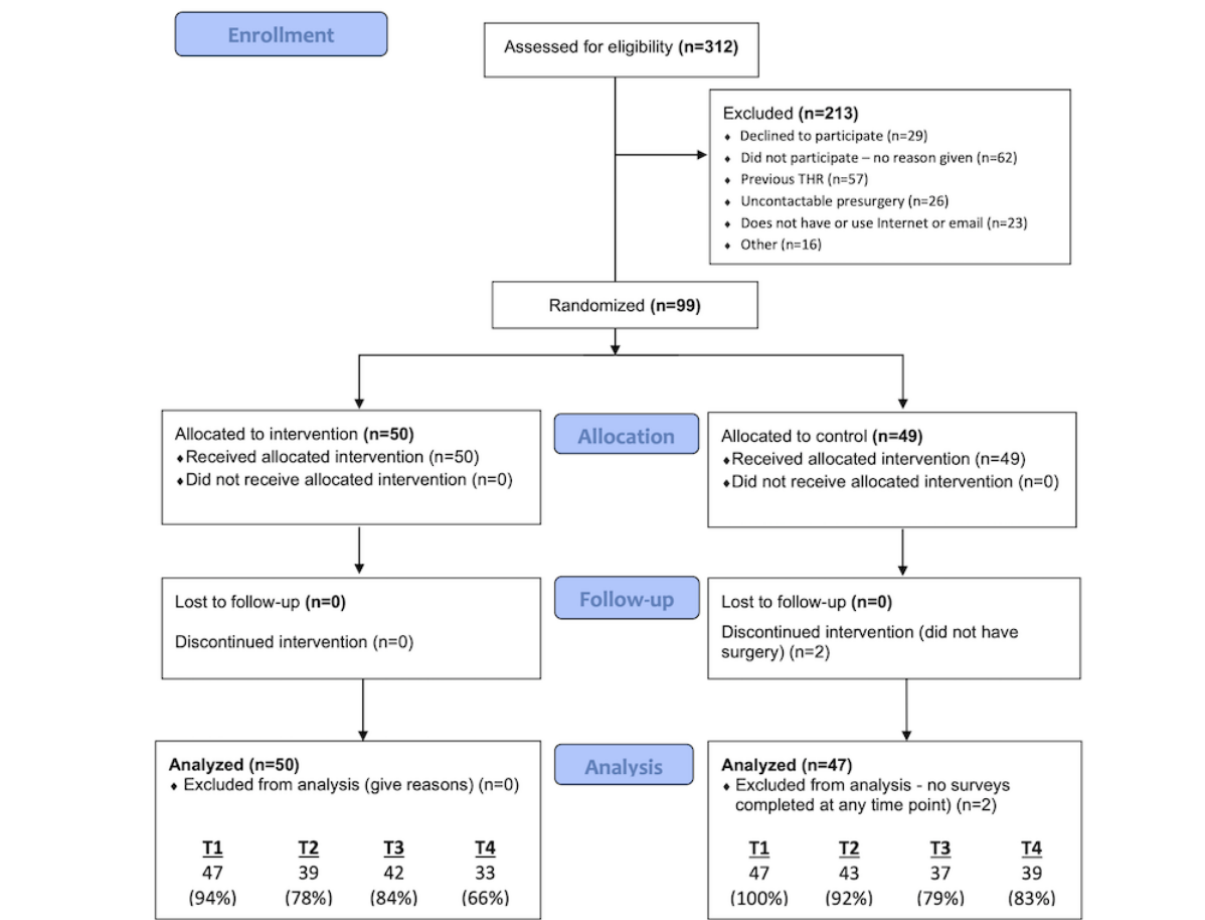
Figure 1. CONSORT (Consolidated Standards of Reporting Trials) flow diagram of patients participating in the